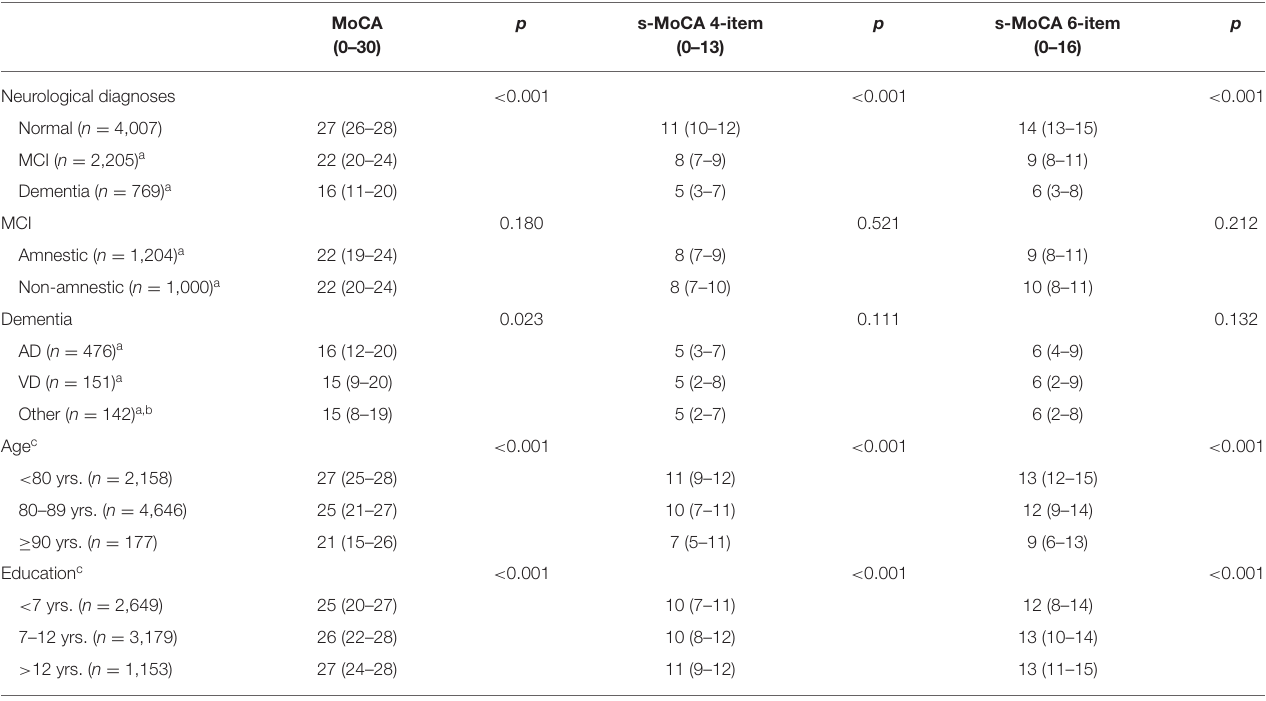
TABLE 2 | MoCA and s-MoCA in a broad neurological sample ( n =